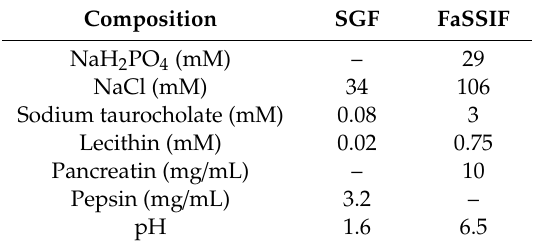
Table 1. Composition of simulated gastrointestinal